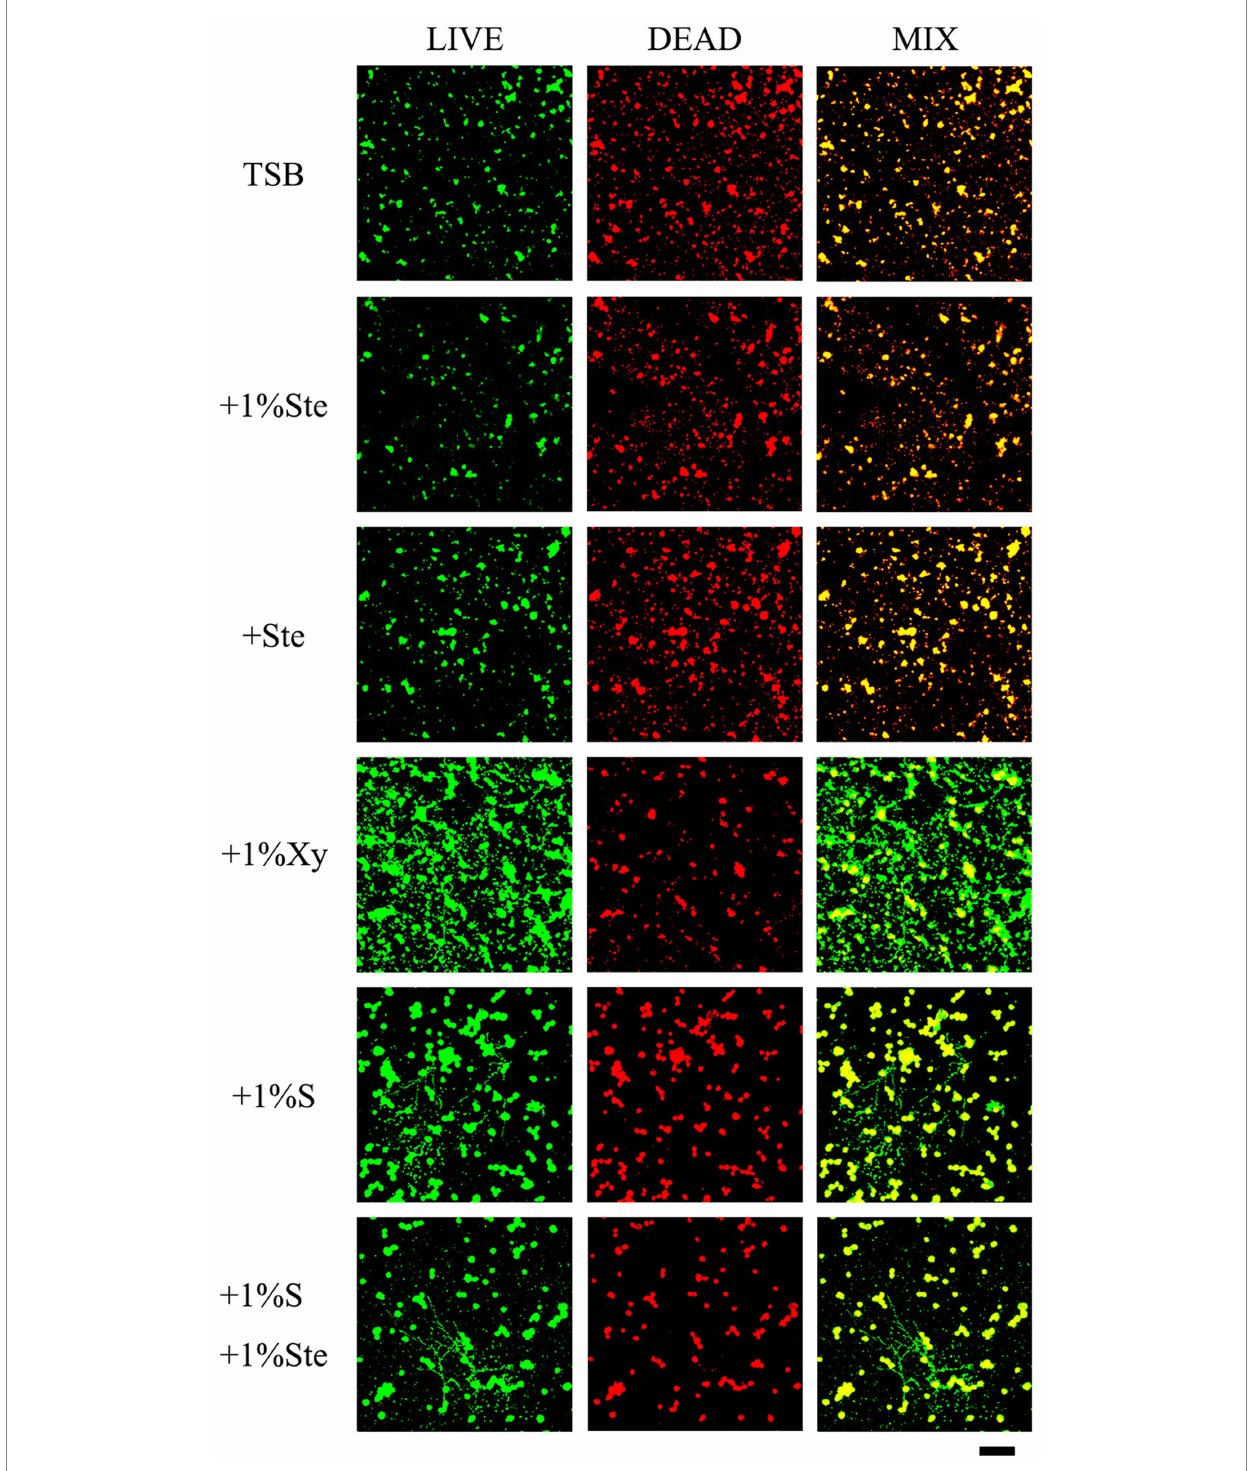
FIGURE 4 Evaluation of stevioside against dual-species biofilms viability by CLSM. Live bacteria/fungi were stained with fluorescent green. Dead bacteria/fungi were stained with fluorescent red. Scale bar: 200 μ